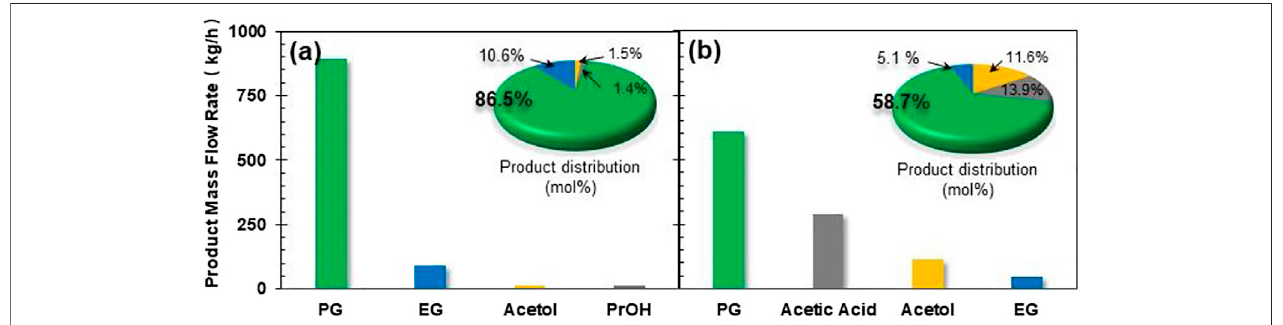
FIGURE 4 | Product distribution and mass fl ow rate for (A) CHDO and (B) CTH of glycerol.